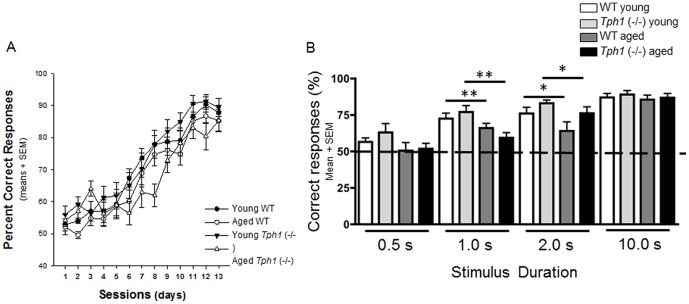
Lack of peripheral serotonin does not result in attention impairment.Ability to learn the association between the stimulus light and reward in WT and Tph1 (−/−) mice showed a strong trend indicating that aged Tph1 (−/−) mice may acquire this association more slowly, however, overtime they demonstrated successful learning across daily sessions (A). Overall, aged mice of both genotypes showed a significant deficit in performance during trials of 1 (**P<0.01) and 2 seconds (*P<0.05) (B).